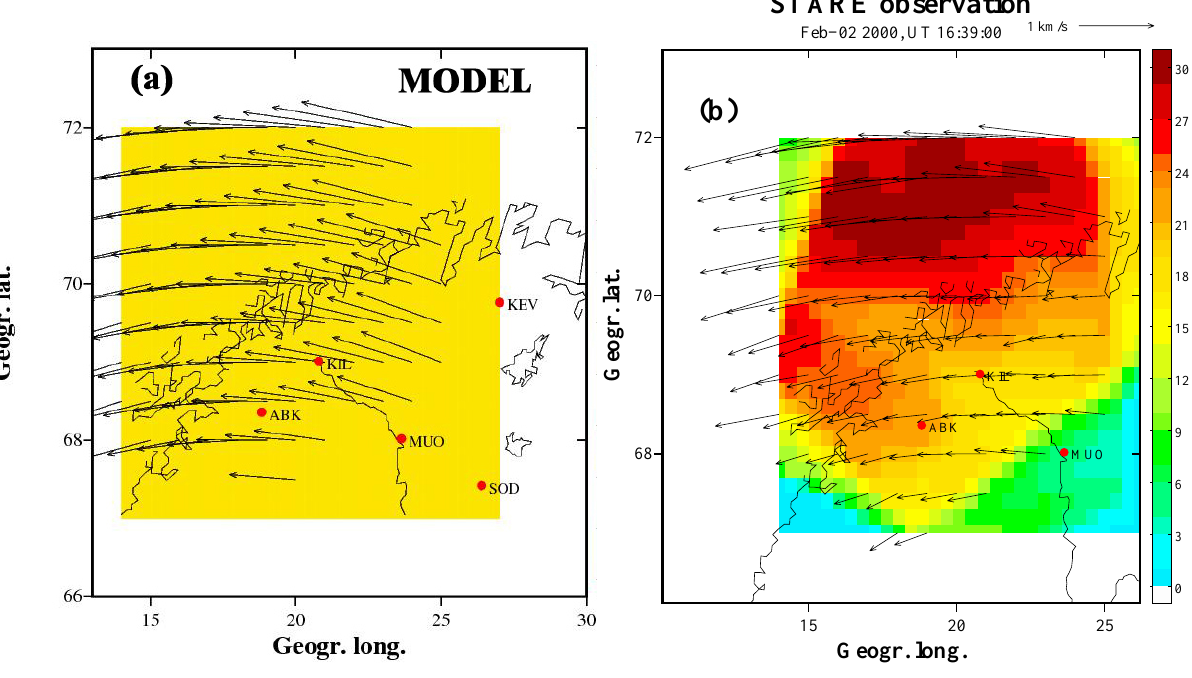
Fig. 7. (a) model: merged vectors configuration assuming no flow angle dependence exists at all: in each antenna beam and range gate V N =470m/s and V F =430m/s, (b) observation: a typical example of the STARE merged vectors configuration in the extensive eastward irr irr electrojet. Note similarity between panels (a) and (b). The colour is mean SNRs of Norway and Finland STARE